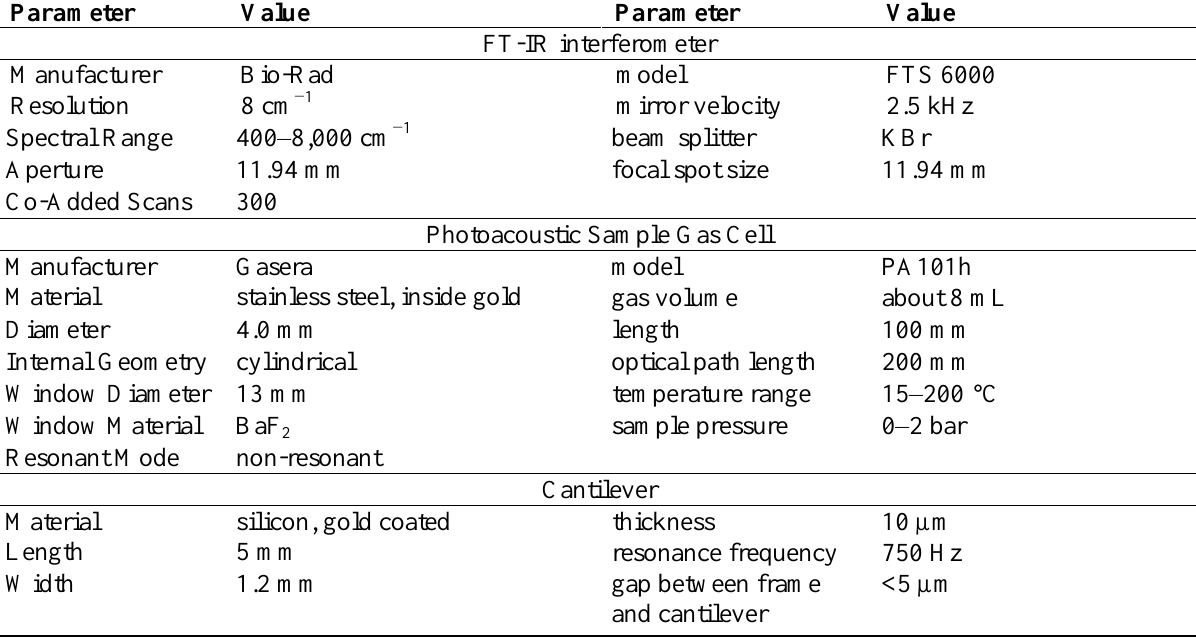
Table 1. Instrument parameters of FT-IR and cPAS